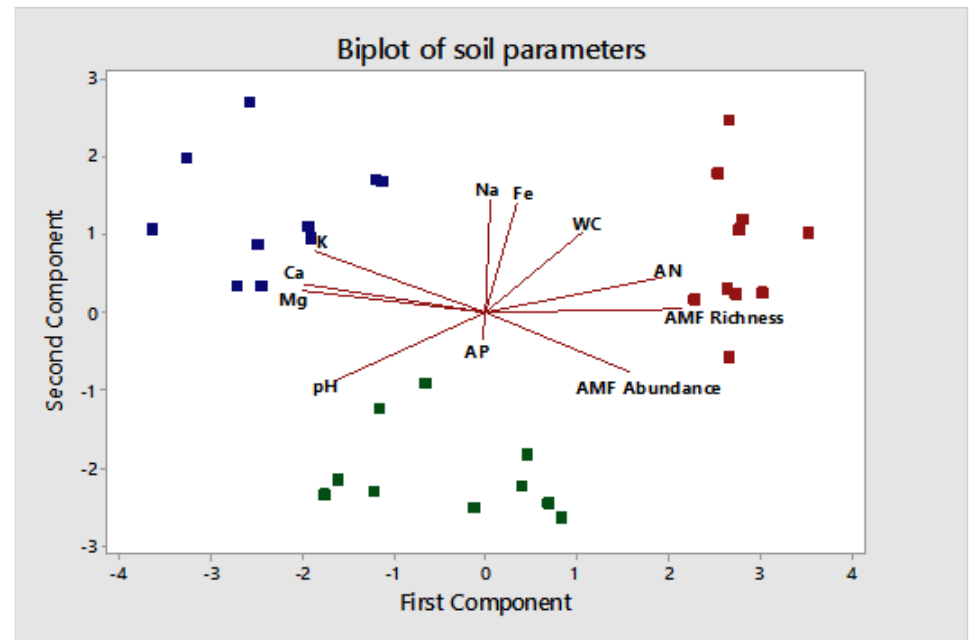
Figure 6: Ordination diagram (drawn with soil parameters, richness and abundance of AMF spores) of the first two components generated in the PCA showing the distinct separation of the three communities, Lowland rainforest (LR), shrub-dominated site (SD) and Dicranopteris -dominated land (DD) in the buffer zone of Kanneliya Forest Reserve, Sri